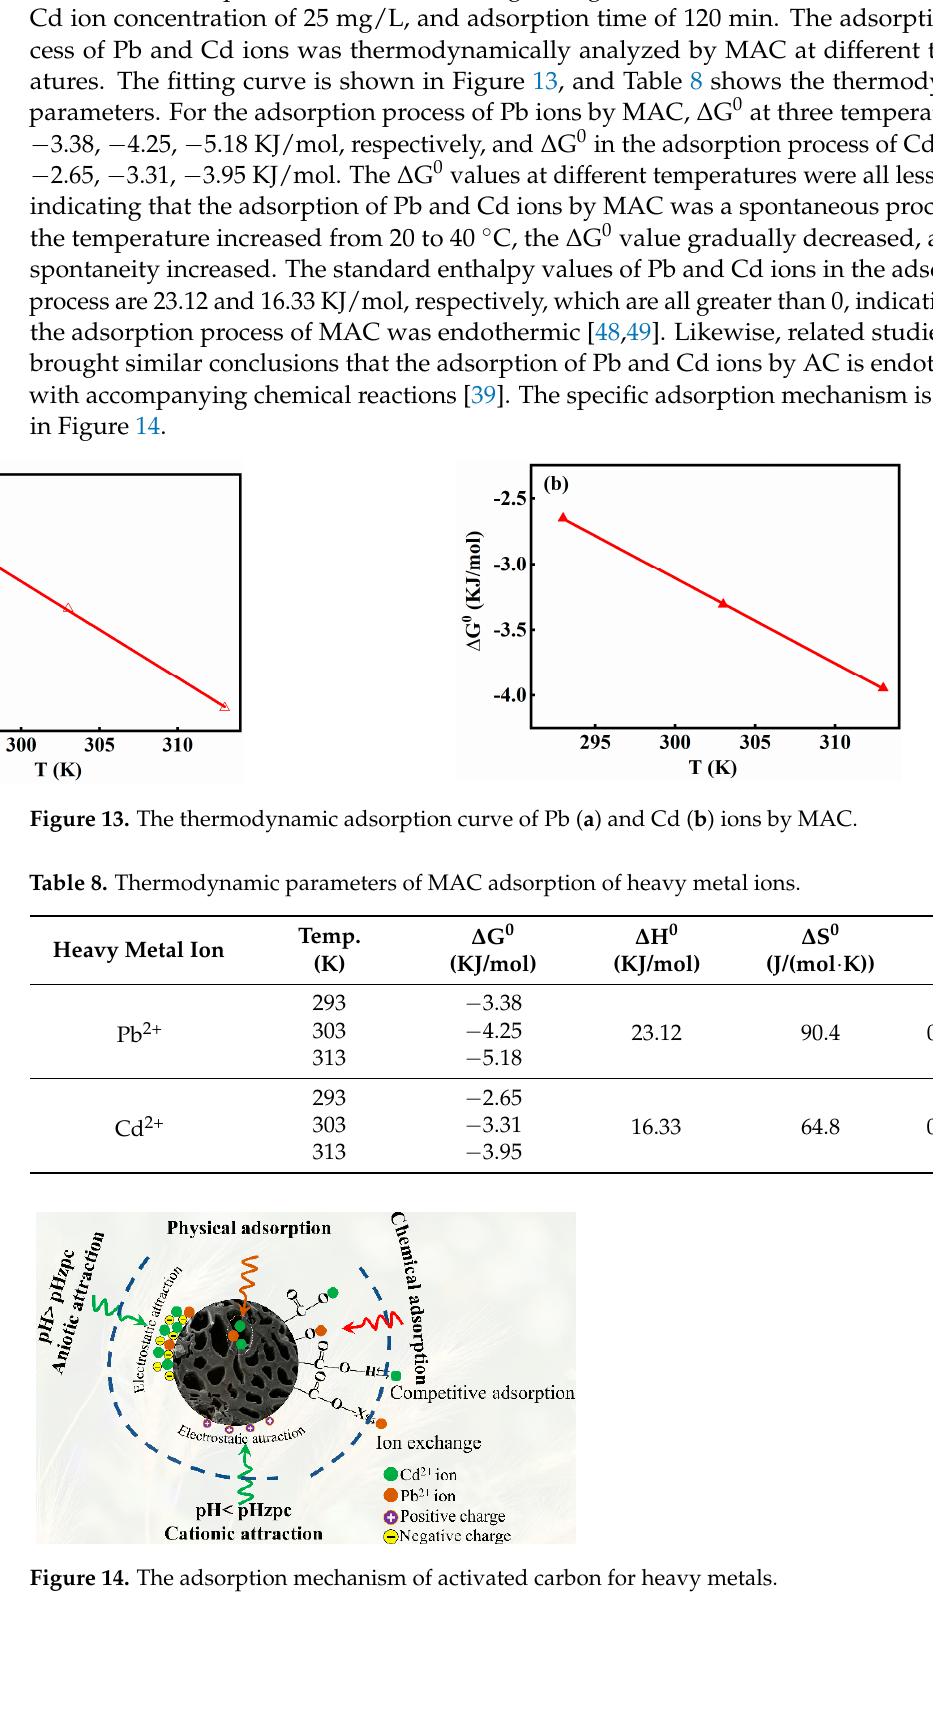
15 of 19 Figure 12. Cd adsorption kinetic model fitting: ( a ) pseudo-first-order model; ( b ) pseudo-second- order model . At the same time, the RMSE value of the pseudo-second-order model (0.2268,0.2352) is smaller than that of the pseudo-first-order model (0.3321,0.3018), which indicates that the pseudo-second-order model can better fit the experimental data. Using the pseudo-